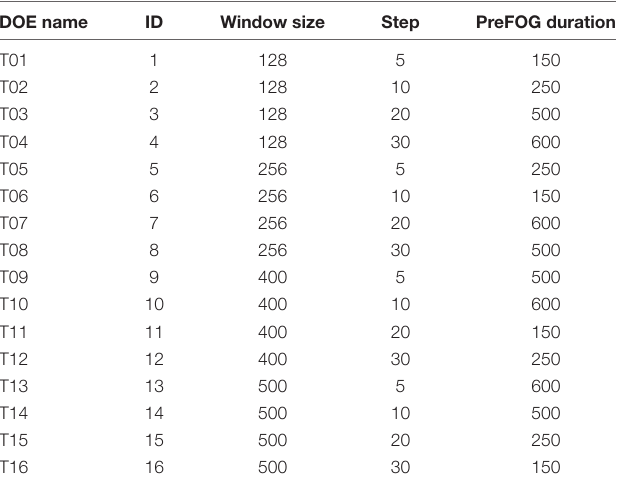
TABLE 3 | Detailed orthogonal experimental design (OED) for optimizing the feature extraction